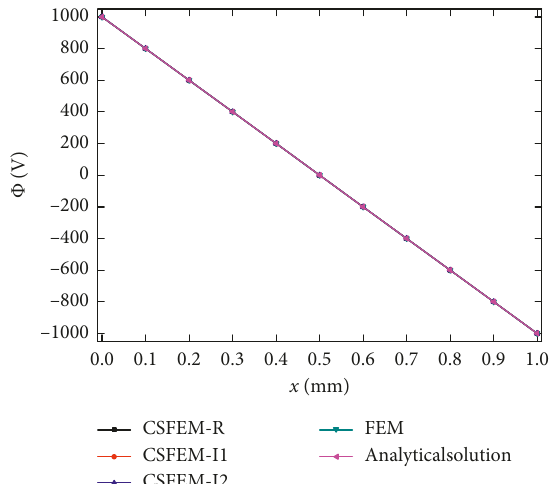
Figure 7: Variation of horizontal displacement u line ( z 0) of the singer-player PCMs (cid:31)